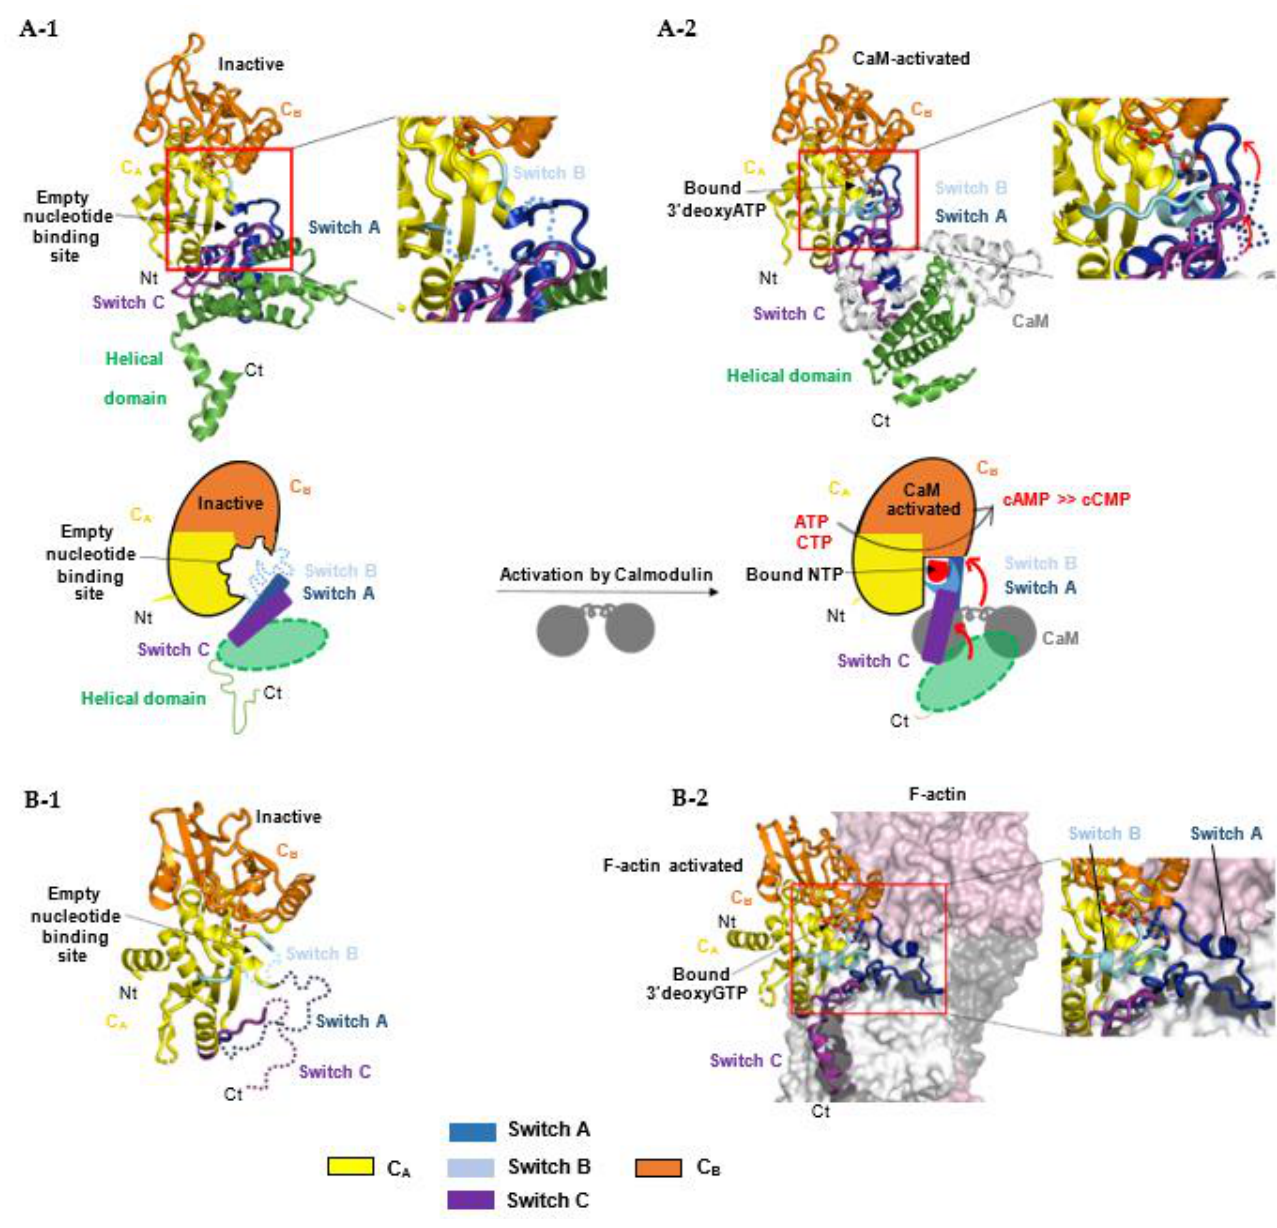
Figure 7. Allosteric activation mechanism of bacterial NC toxins by calmodulin ( A ) or F-actin ( B ) by stabilization of their nucleotide-binding pocket and catalytic site upon interaction with their cofactor. ( A ) The upper panel represents the different conformations of EF NC toxin during its activation process: ( A-1 ) Free, inactive EF (PDB: 1k8t) [37]; in the absence of CaM, switch B is disordered (cyan dashed line). ( A-2 ) CaM-activated EF with 3 ′ dATP and a single metal ion Yb 3+ in its active site (PDB: 1k90) [37]. CaM (white) inserts itself between the adenylate cyclase domain EF – AC domain (yellow) and the helical domain (green) of EF. The lower panel represents re- spective schematic models: CaM binding induces a large conformational movement of the interface regions switch A (dark blue) and C (purple) resulting in the stabilization of switch B, which contains residues that either bind ATP directly or stabilize catalytic residues in the groove between C A and C B domains [37]. The conformation of switch A and C regions in the absence of CaM are shown in blue and purple dashed lines respectively. ( B ) ( B- 1 ) Structure of free, inactive Pa -ExoY crystallized by limited in situ proteolysis (PDB: 5xnw) [38] with its switch regions, which are partially proteolyzed, dynamic or disordered in the crystal structure, shown in dashed lines. ( B-2 ) Structure of F-actin-activated Pa -ExoY with 3 ′ dGTP and a single metal ion Mg 2+ in its active site solved by cryo-electron microscopy (PDB: code: 7p1g) [39]. All these structural studies, together with mutational and biochemical analyses [29,30,32,33,37,137,143,145 – 147], provide key insights into how the overall structures and catalytic sites of class III and class II AC are organized and modulated by their different